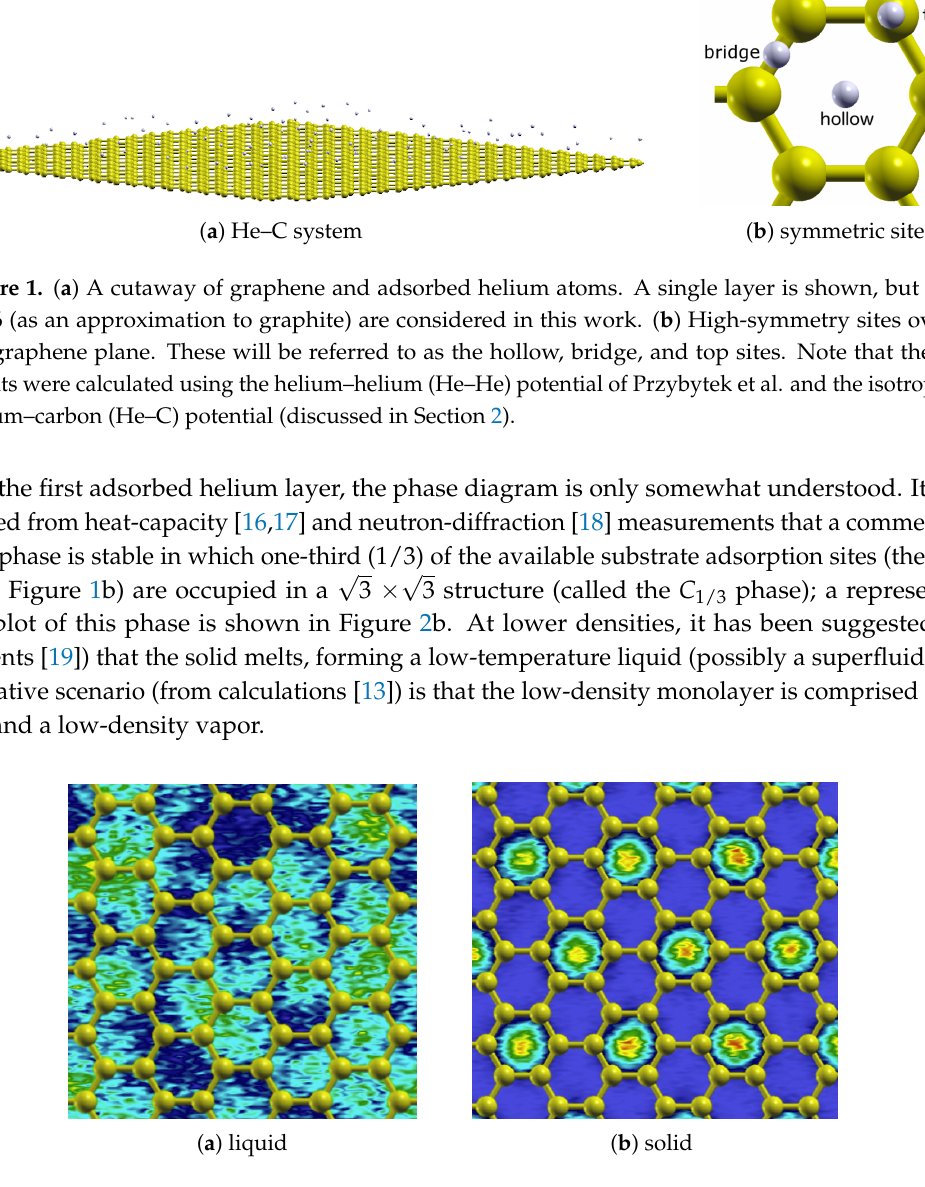
Figure 2. Density plots of ( a ) the liquid, at the equilibrium density, and ( b ) solid ( C 1/3 ) phases. See the text for (general) details. Note that these results were calculated using the He–He potential of Przybytek et al. and the isotropic He–C